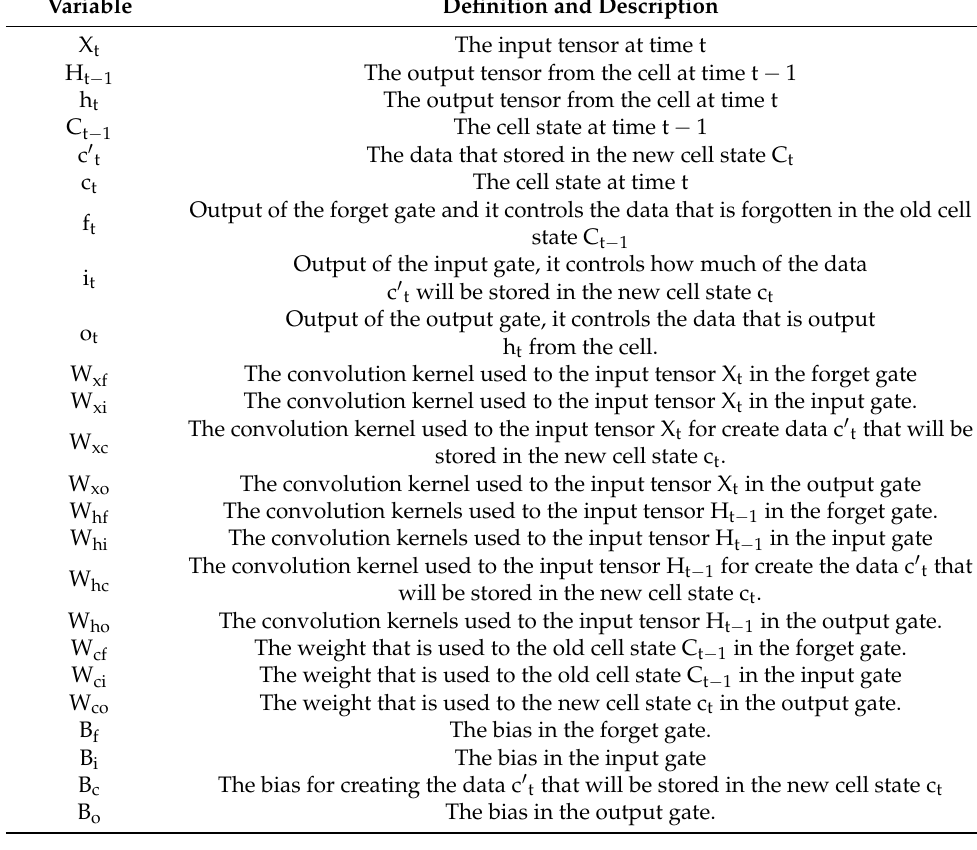
Table 4. Definition and description of the variables used in Conv-LSTM model [36].